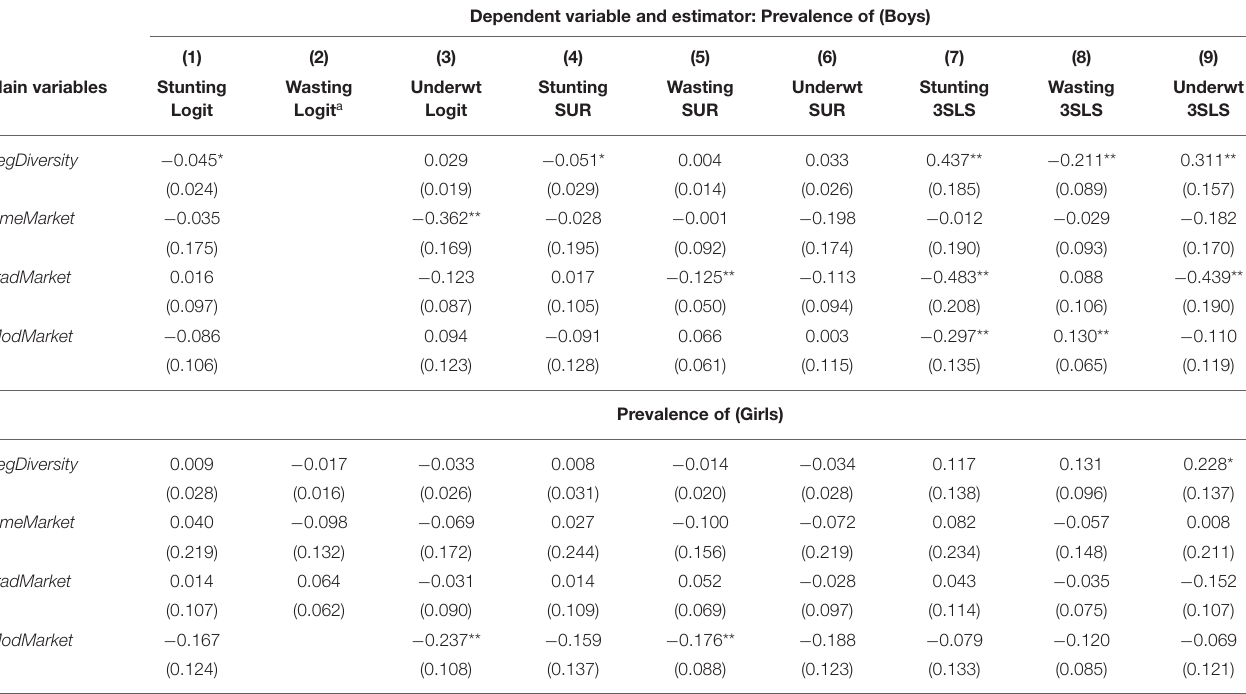
TABLE 5 | Impact of smallholder vegetable production on the prevalence of stunting, wasting, and underweight of sampled boys and girls. Dependent variable and estimator: Prevalence of